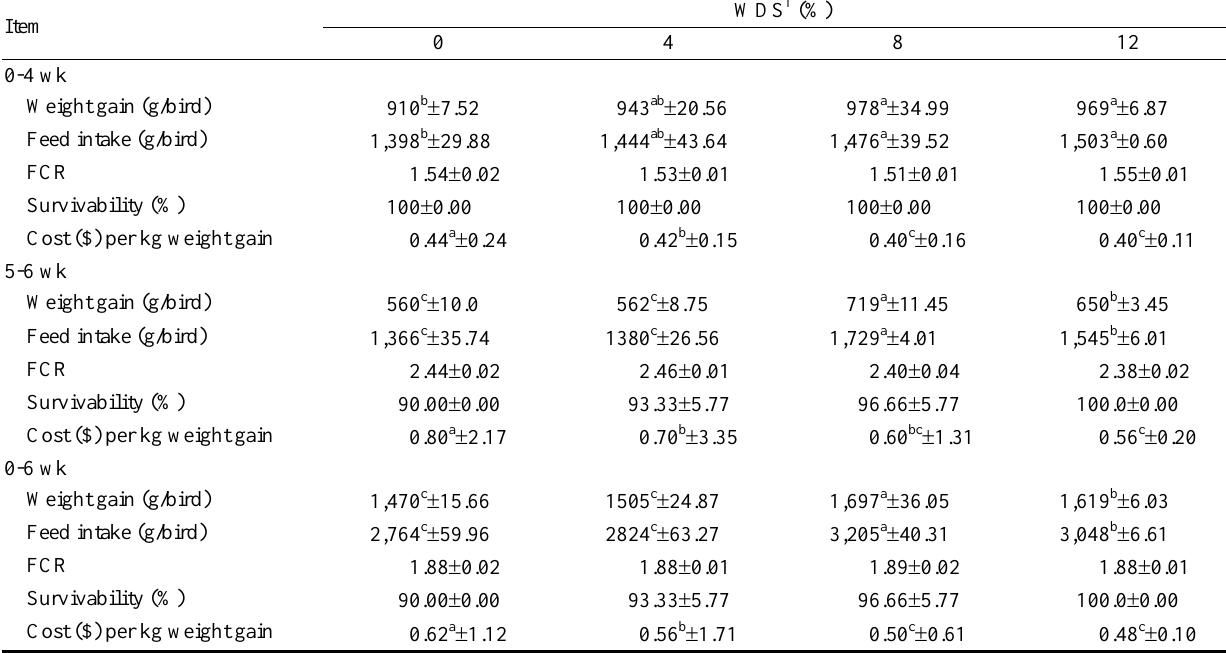
1 0, 4, 8 and 12 WDS indicates percent inclusion of washed distillery sludge in the diets. Means in a row with different superscripts differ significantly (p<0.01).